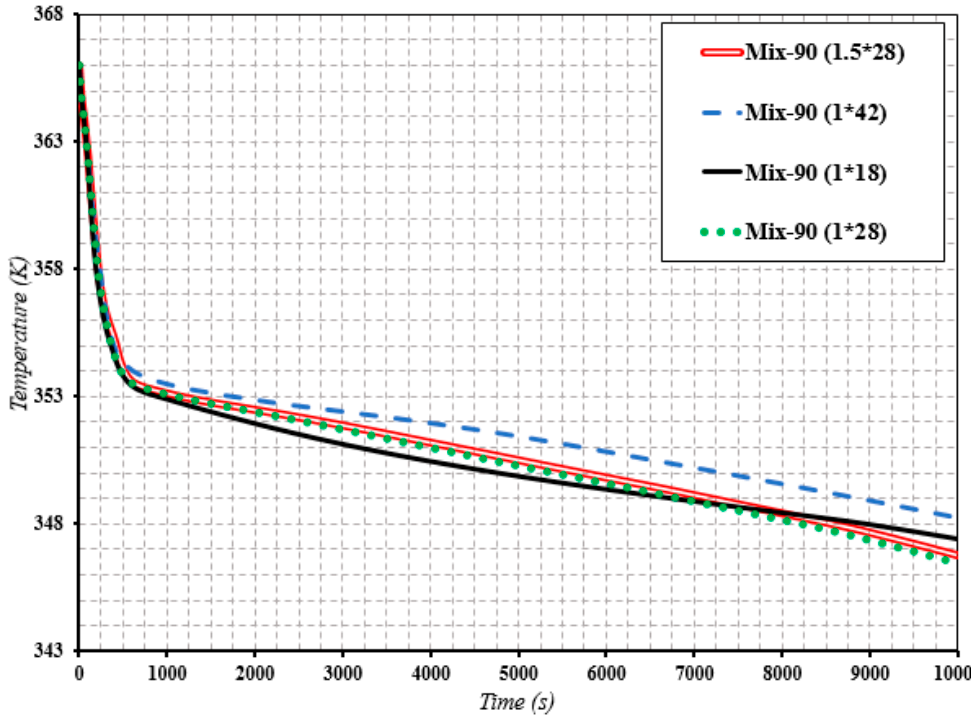
Figure 11. The average temperature during the time for the PCM area with different fins’ dimensions.